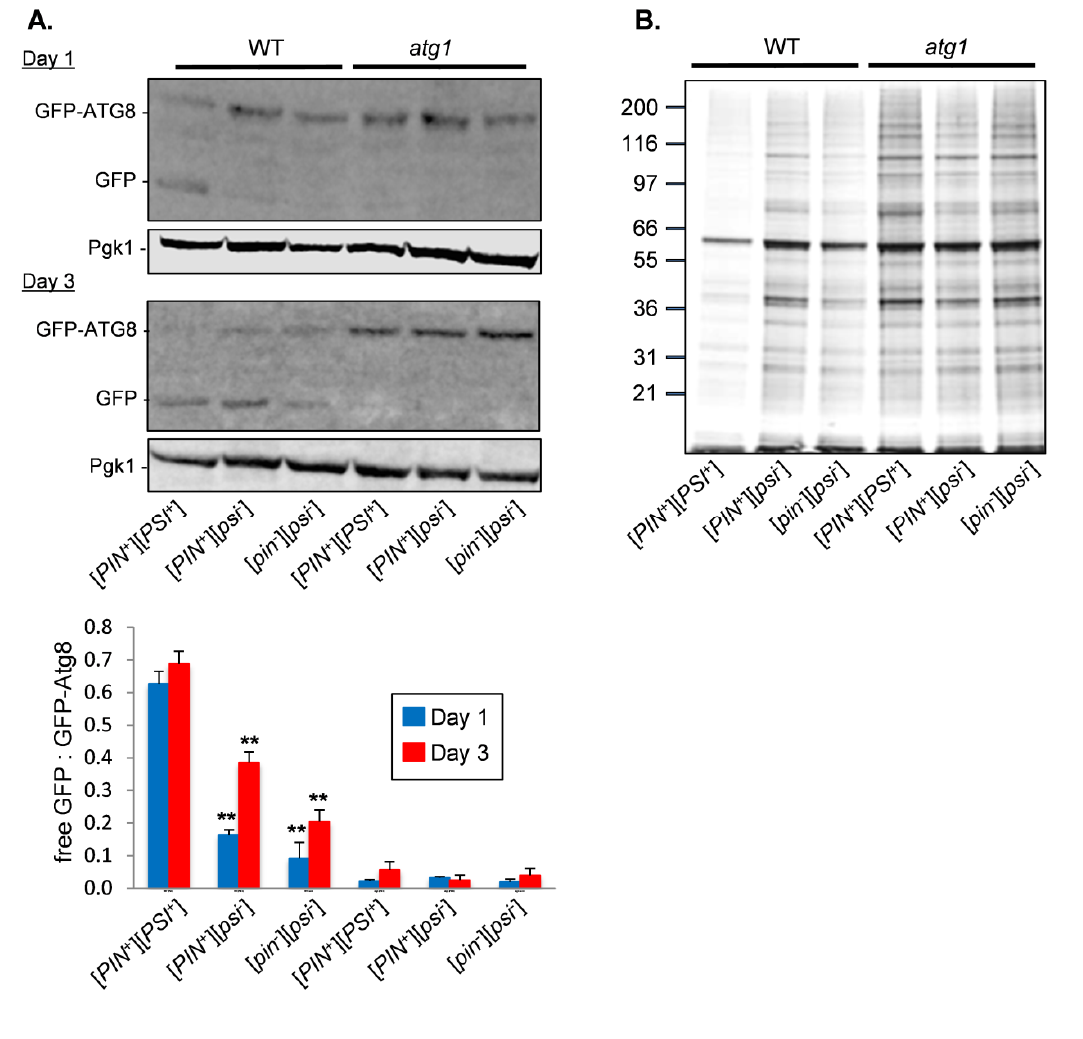
FIGURE 3: Increased autophagic flux in [ PSI + ] strains. (A) Autophagic flux was monitored in in the indicated strains expressing GFP-Atg8 during late exponential (day 1) and stationary phase growth (day 3). Increased free GFP is detected in the [ PIN + ][ PSI + ] strain indicative of autophagic flux. No free GFP is detected in the atg1 mutant strains which cannot initiate autophagy. Representative images are shown from triplicate experiments with quantification comparing the ratios of free GFP with GFP-Atg8 below. Significance is shown comparing the [ PIN + ][ PSI + ] versions of the wild-type and atg1 mutant strains with their corresponding [ PIN + ][ psi - ] and cured [ pin - ][ psi - ] versions. Statistical analysis was performed by one-way ANOVA: * p < 0.05, ** p < 0.01. (B) Protein aggregates were isolated from the same strains as shown in panel A at day three of chronological growth and analyzed by SDS-PAGE and silver